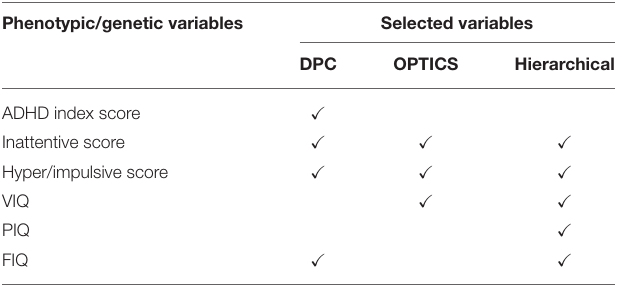
TABLE 1 | Phenotypic variables selected by GA with different clustering methods (ADHD). Phenotypic/genetic variables Selected variables